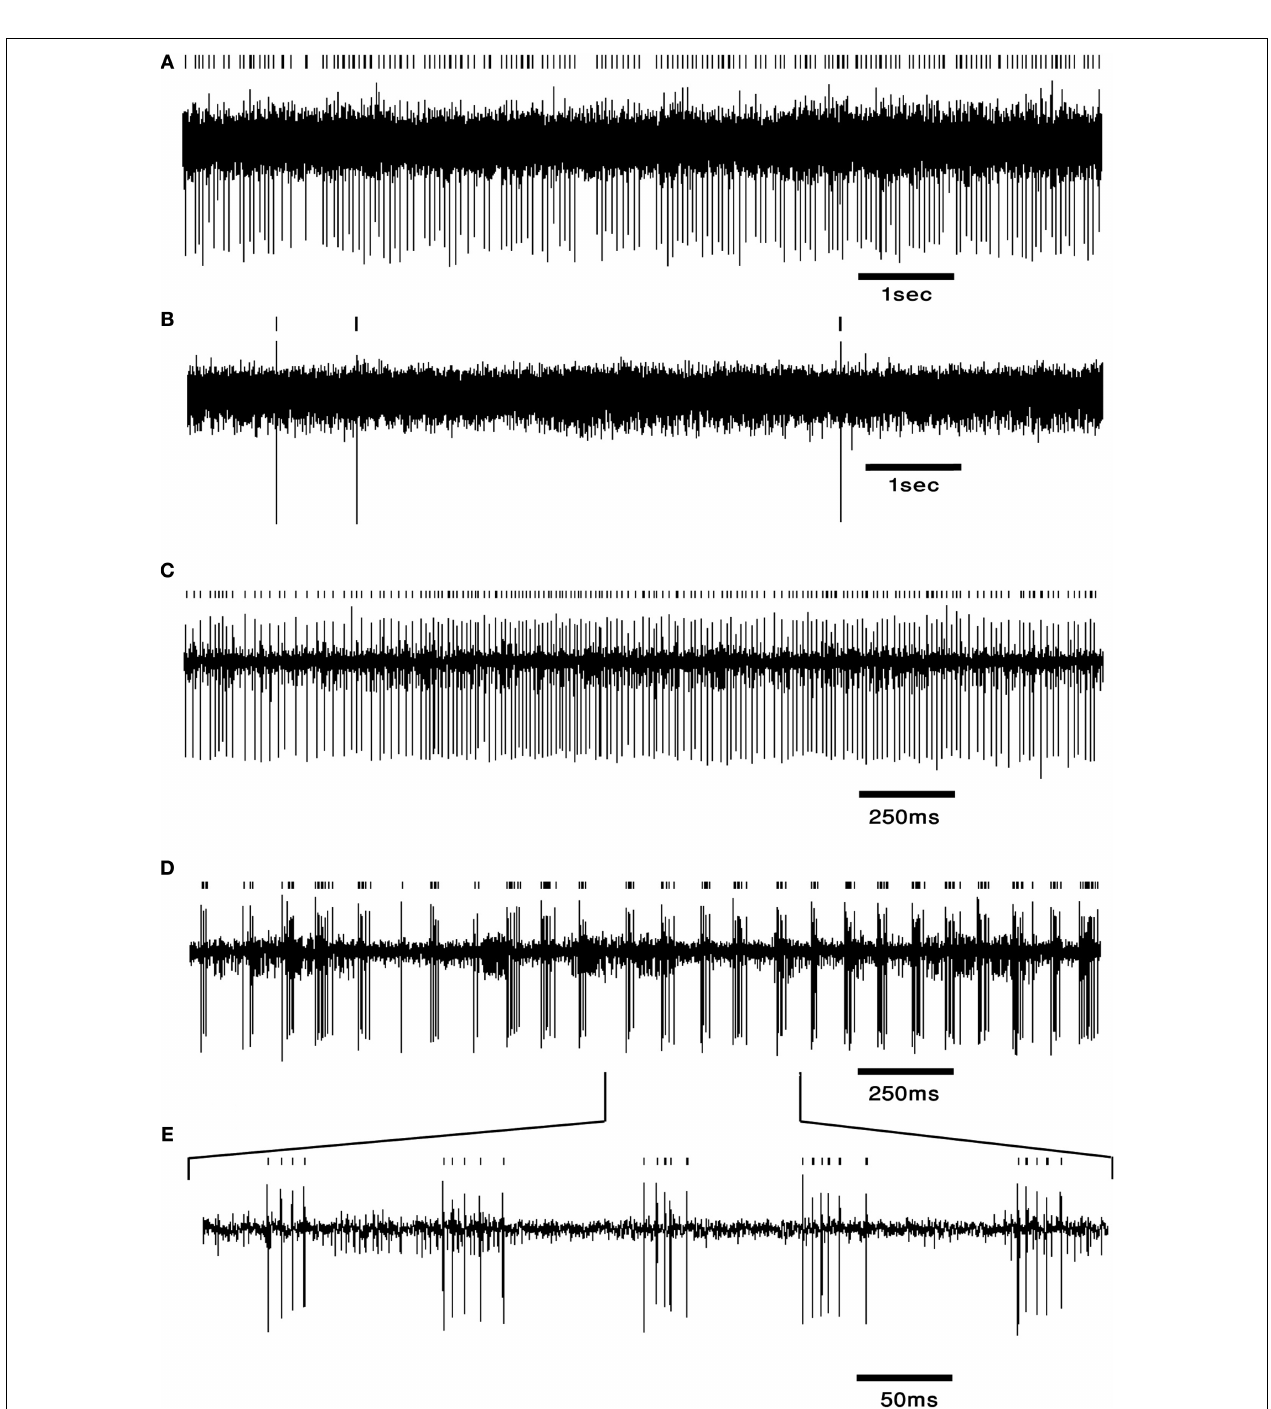
FIGURE 3 | DCN neurons exhibit typical fi ring patterns following harmaline injection. (A,B) An example of a tonically fi ring neuron (A) that became almost completely quiescent after harmaline injection (B) . (C,D) An example of a tonically fi ring neuron (C) that exhibited an ON/OFF fi ring pattern after harmaline injection (D) . (E) Time expansion of the marked section in (D) showing the typical cycle of the ON/OFF pattern. Small bars above the trace mark the sorted spikes. The surgical procedure has been described in detail (Cohen and Nicolelis, 2004; Jacobson et al., 2009). In brief, adult Long Evans male rats weighing 350– 500 g (Harlan, Indianapolis, IN, USA) were initially sedated by 5% isofl urane and